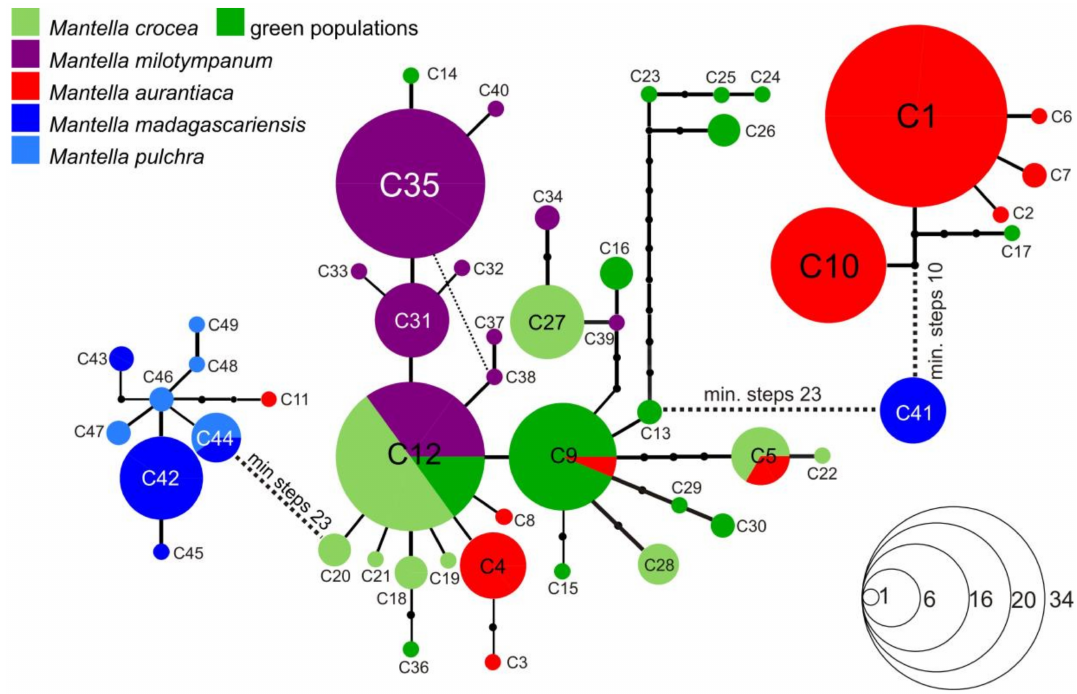
Figure 3. Haplotype network of 49 unique COB haplotypes of Mantella crocea (green; darker green highlights the haplotypes found in the populations that show the green phenotype), M. milotympanum (orange), M. aurantica (red), M. madagascariensis (blue) and M. pulchra (light blue), based on the analysis of a 552-bp DNA fragment of this mitochondrial gene. Size of circles is proportional to the number of individuals sharing a given haplotype (haplotype frequencies as in the inset legend). Shared haplotypes are indicated by circles, with the area being proportional to the number of individuals sharing that haplotype. Inferred intermediate haplotypes are indicated by small black